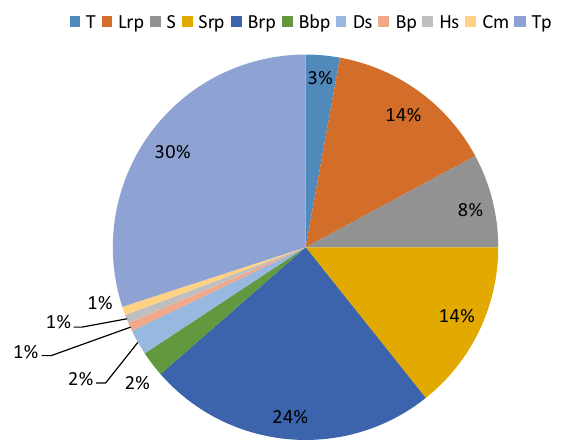
Fig. 8 Life forms composition the floristic composition of the habitats according to Serebryakov (1962): T, tree; S, shrub; Hs, half-shrub; Ds, dwarfshrub; Lrp, long rhizomatous plant; Srp, short rhizomatous plants; Bbp, bulbotuberiferous plants; Tp, taproot plants; Brp, brushy root plants; Cm, club-moss